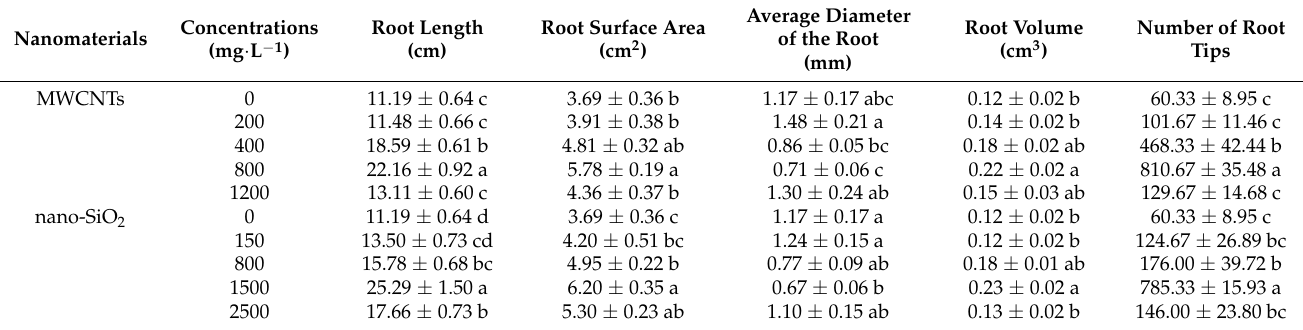
Table 2. Effect of different concentrations of MWCNTs and nano-SiO 2 on seedling root morphology in